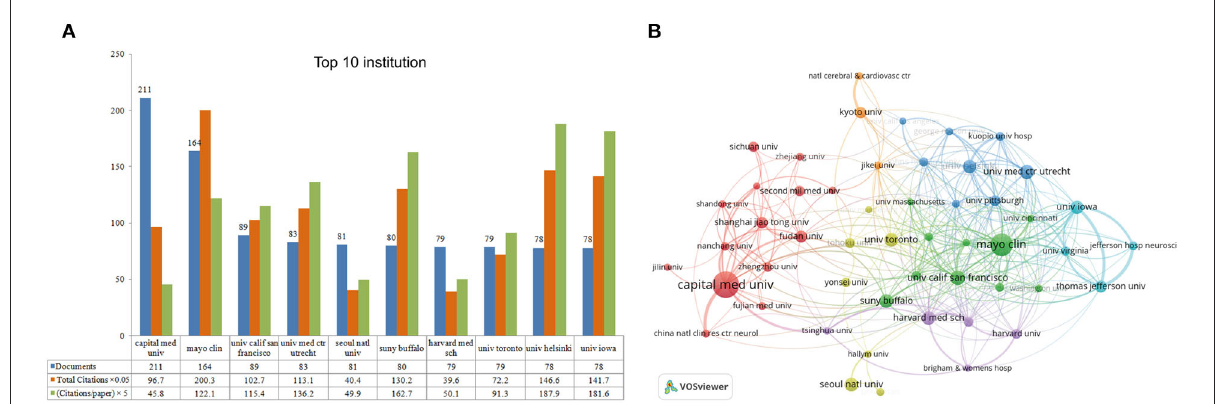
FIGURE4 The top 10 most productive institutions and inter-institutional cooperation of IA research from 2012 to 2021. (A) The number of publications, citations ( × 0.05), and citations per paper ( × 5). (B) The cooperative map of institutions for IA visualized by VOSviewer. Node size indicates the number of articles produced. The width of links is positively associated with the cooperation strength.